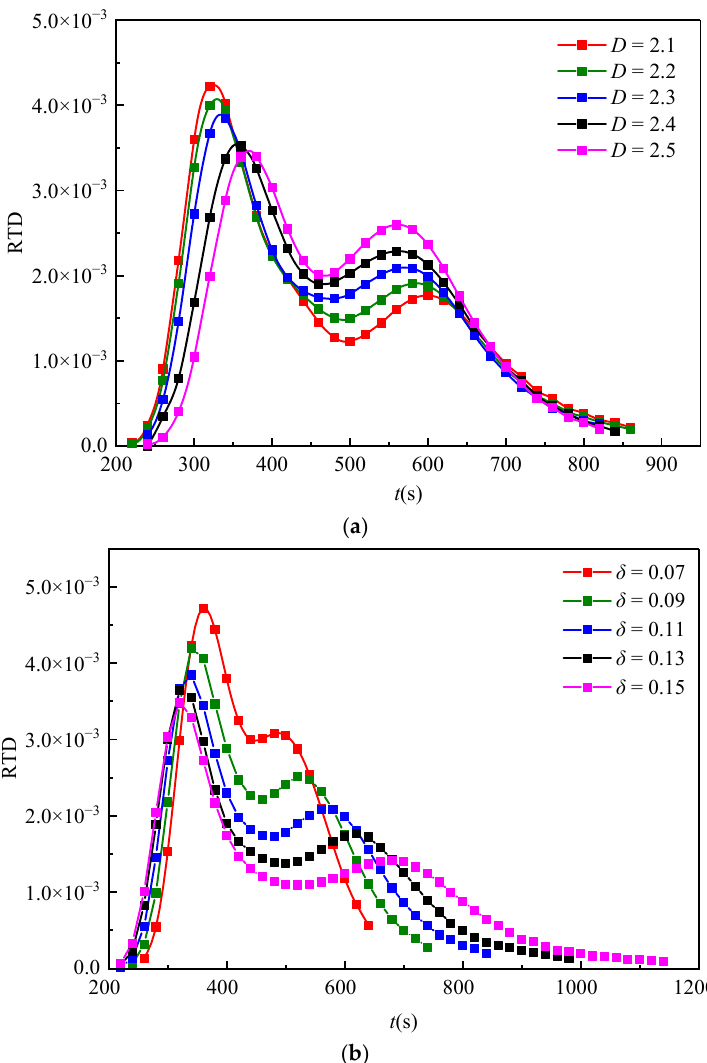
Figure 9. ( a ) RTD curves of different fractal dimensions; ( b ) RTD curves of different standard deviation of aperture.